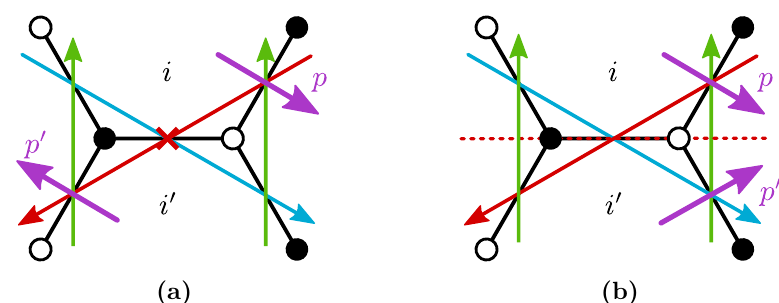
Figure 7. The orientifold actions with fixed points (a) and fixed lines (b). p is a path from one face to an adjacent one, and p 0 its image. In (a) the red and blue ZZPs are self-identified, while the green ones are mapped into each other. In (b), the red and blue ZZPs are mapped into each other, and the green ones are self-identified.